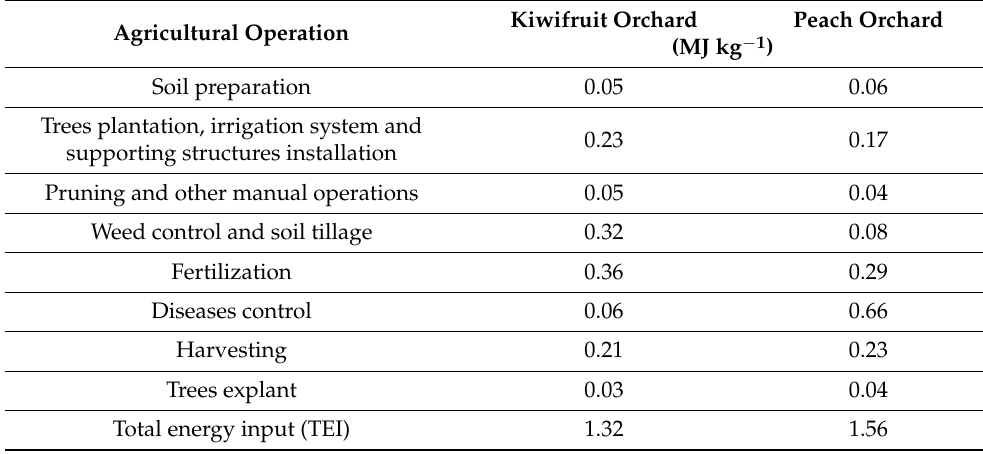
Table 4. Energy consumption per kg of product from the examined fruit orchard systems (kiwifruit and peach orchards) in the whole production cycle (20 and 15 years for kiwifruit and peach orchards, respectively).